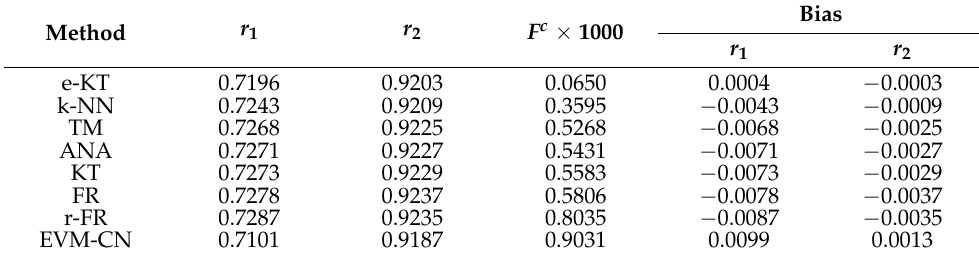
Table 13. Reactivity ratios obtained in the imposed conditions of